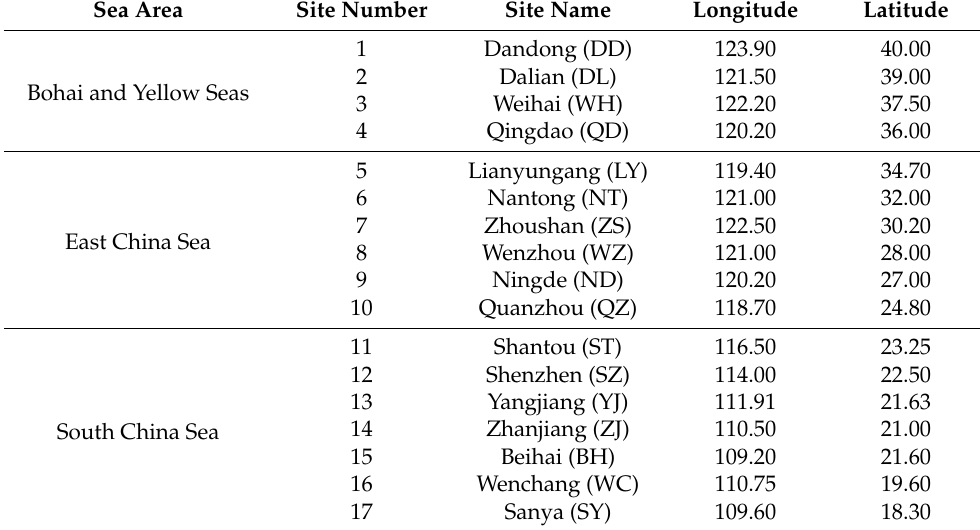
Table 1. Geographical information of fishing